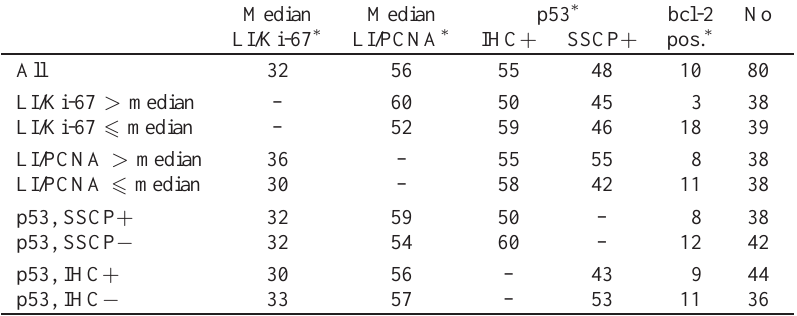
Table 1 Summary of immunohistochemical data regarding Ki-67, PCNA, p53 and bcl-2